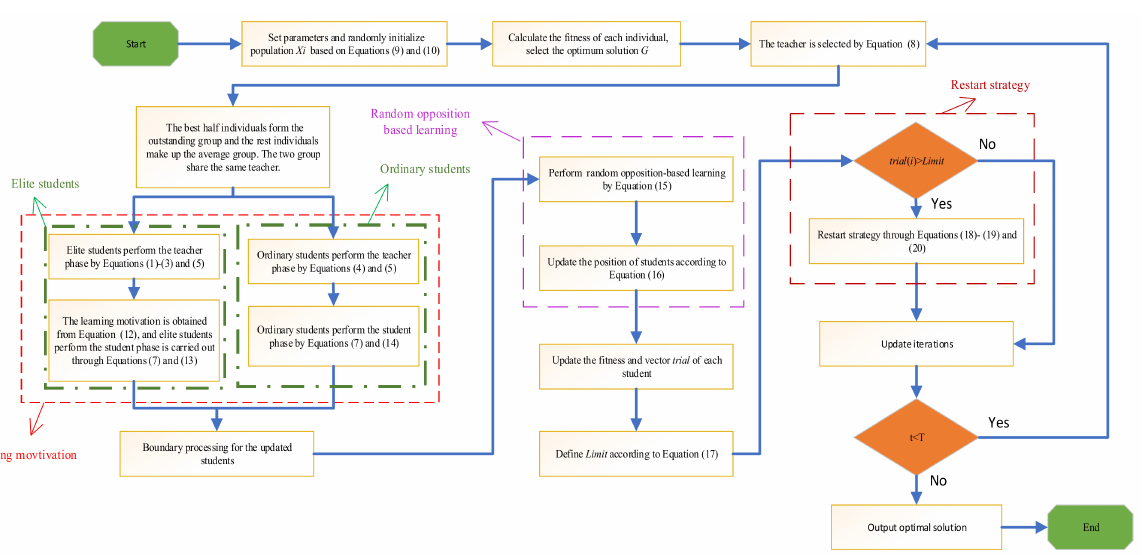
Figure 2. Flowchart for proposed